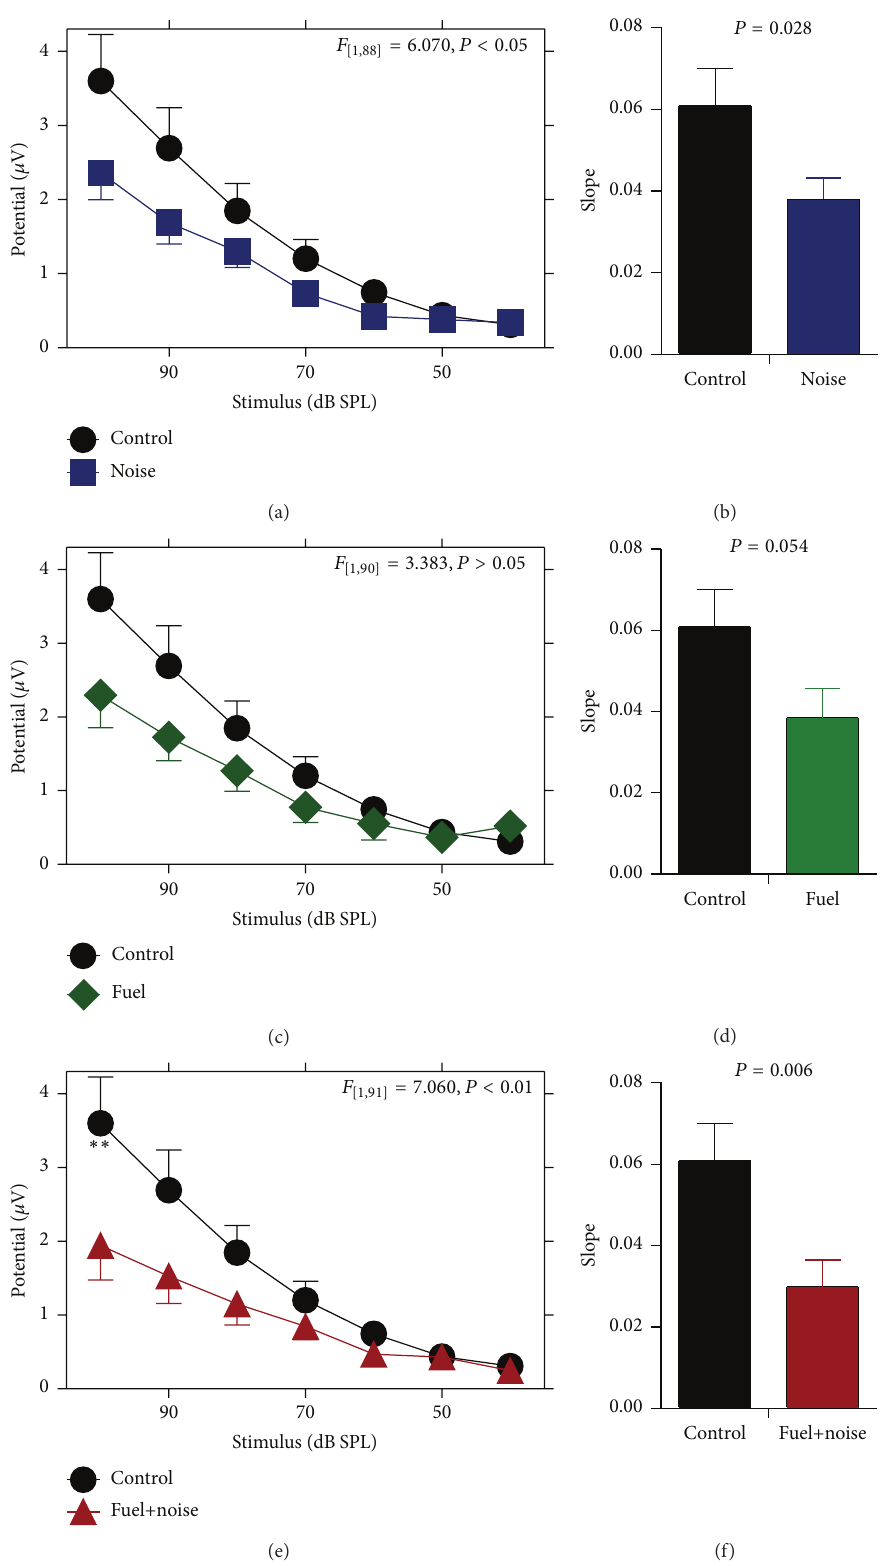
Figure 4: Abnormal response magnitude. The potential difference between P 2 and N 0 was measured for each exposure group and compared to that of the nonexposed (control) group. (a) After noise exposure there was a reduction in stimulus response magnitude across a wide range of stimulus levels. (b) This was further confirmed with a truncated stimulus response growth rate (slope). (c and d) Similar, but less severe outcomes were observed after fuel-only exposure. (e and f) Combined exposure to fuel and noise resulted in a significant reduction in stimulus response magnitude which was further supported by a truncated